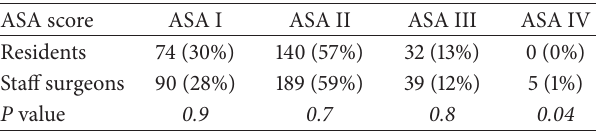
Table 1: ASA (American Society of Anaesthesiologists) score of the patients operated by residents and staff surgeons.